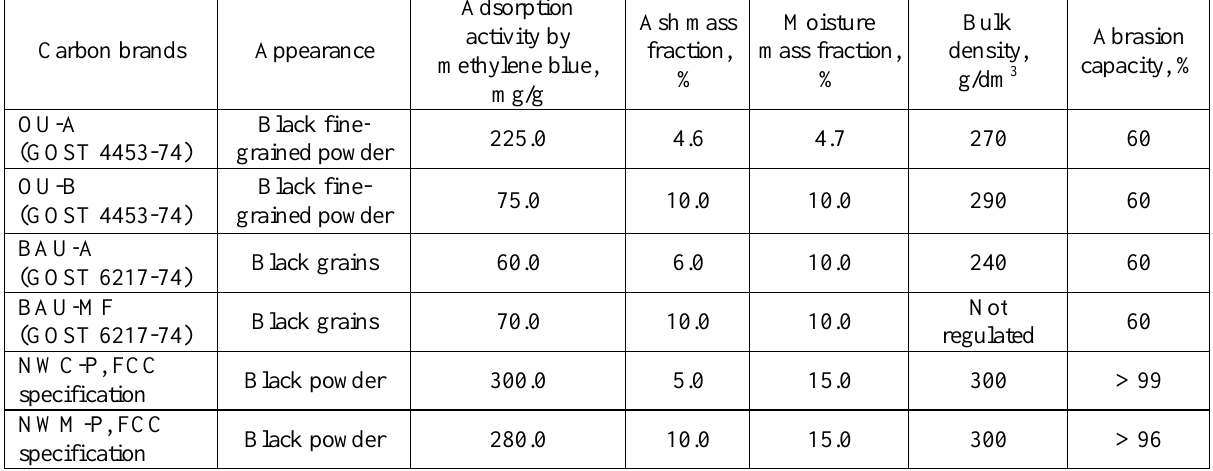
Table 1. Physical and chemical parameters of activated carbons of different brands [9]